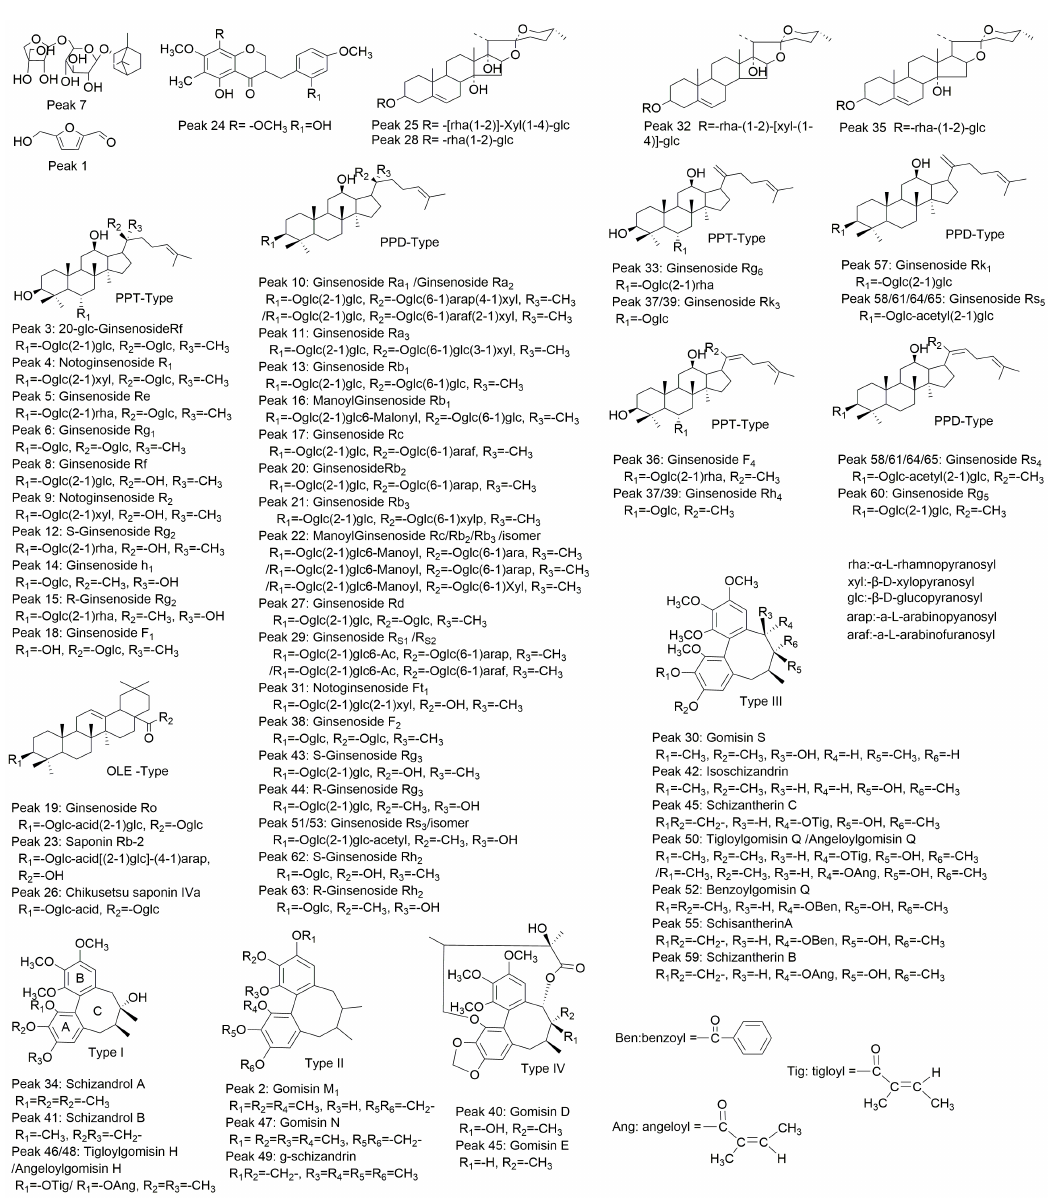
Figure 3. The structures of the sixty-five components identified from YiQiFuMai injection.